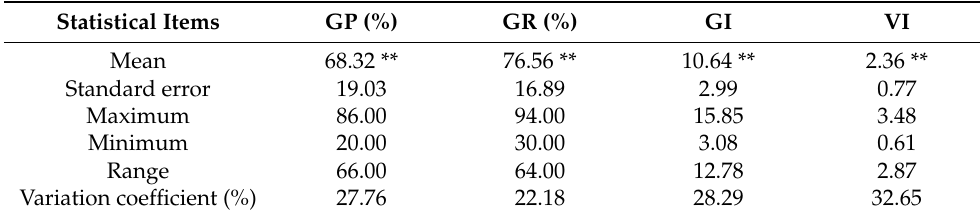
Table 3. Variation in the seed vigor indexes of 34 soybean strains included in the regional test in Huanghuaihai, China, in 2021.